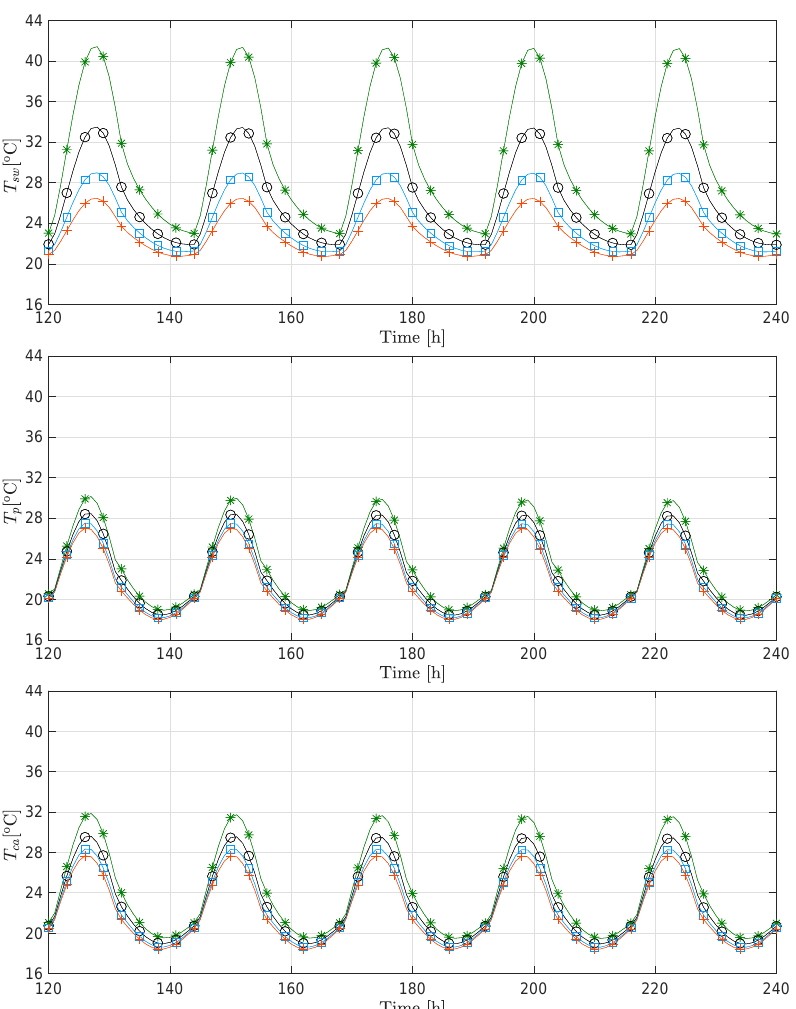
Figure 10. Facade surface temperature T sw (above), plant temperature T p (in the middle) and canopy air temperature T ca (below) distribution over time—shortwave extinction coefficient parameter, k s : ( ∗ ) 0.3; ( ◦ ) 0.5; ( (cid:3) ) 0.7; (+)